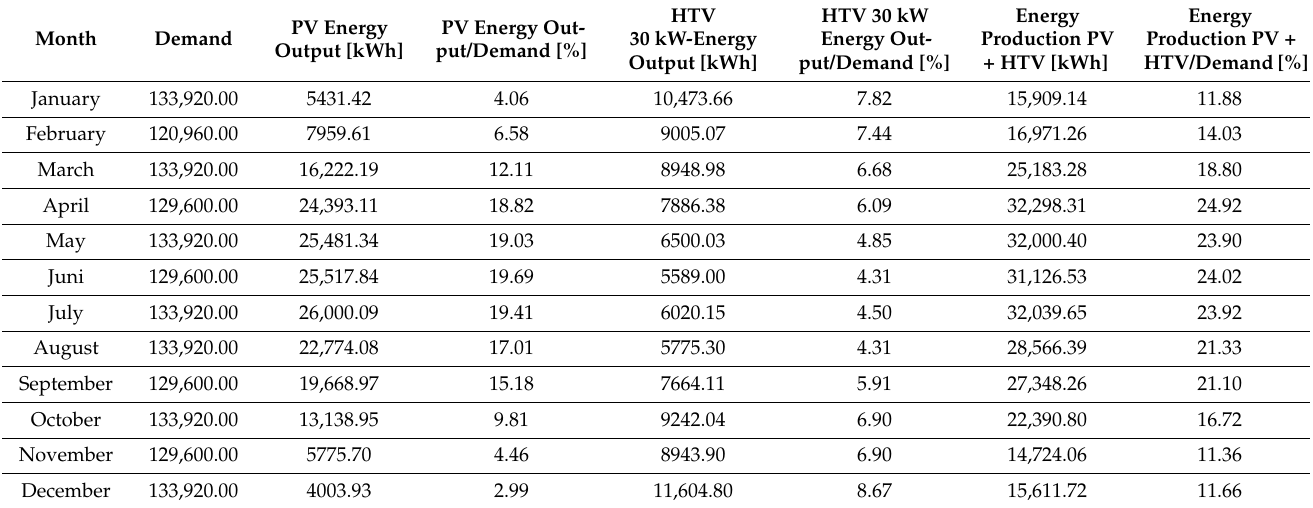
Table 10. Average amounts of energy generated by PV installations and windmill systems with